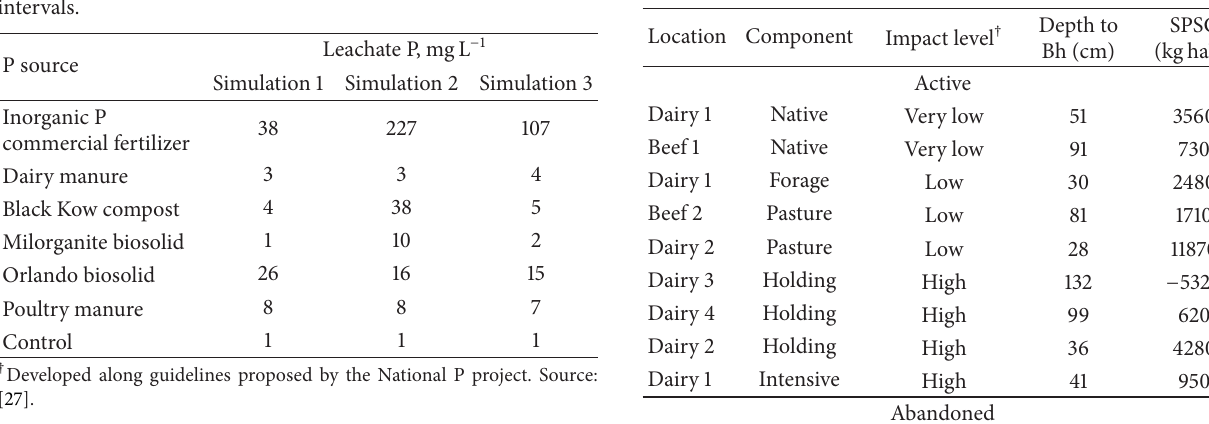
Table 2: Soil phosphorus storage capacity (SPSC) of selected dairy and beef soil profiles to 120 cm